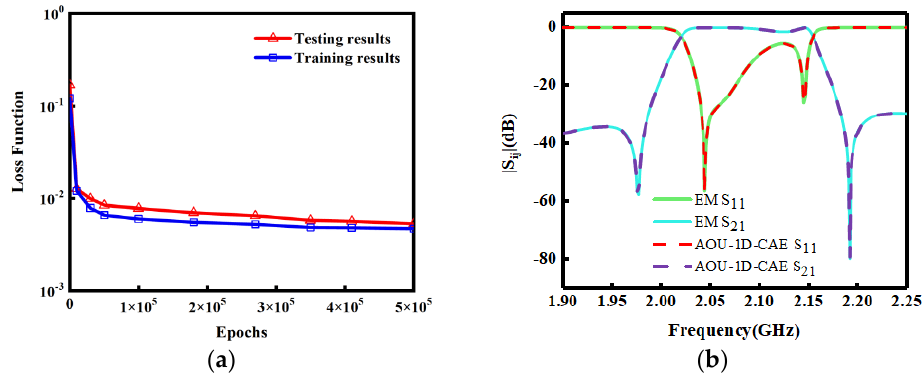
Figure 10. ( a )AOU−1D−CAE neural network training and testing result. ( b ) Fourth−order cavity fil- Figure 10. ( a ) AOU − 1D − CAE neural network training and testing result. ( b ) Fourth − order cavity ter HFSS simulation results with surrogate model network prediction results. filter HFSS simulation results with surrogate model network prediction